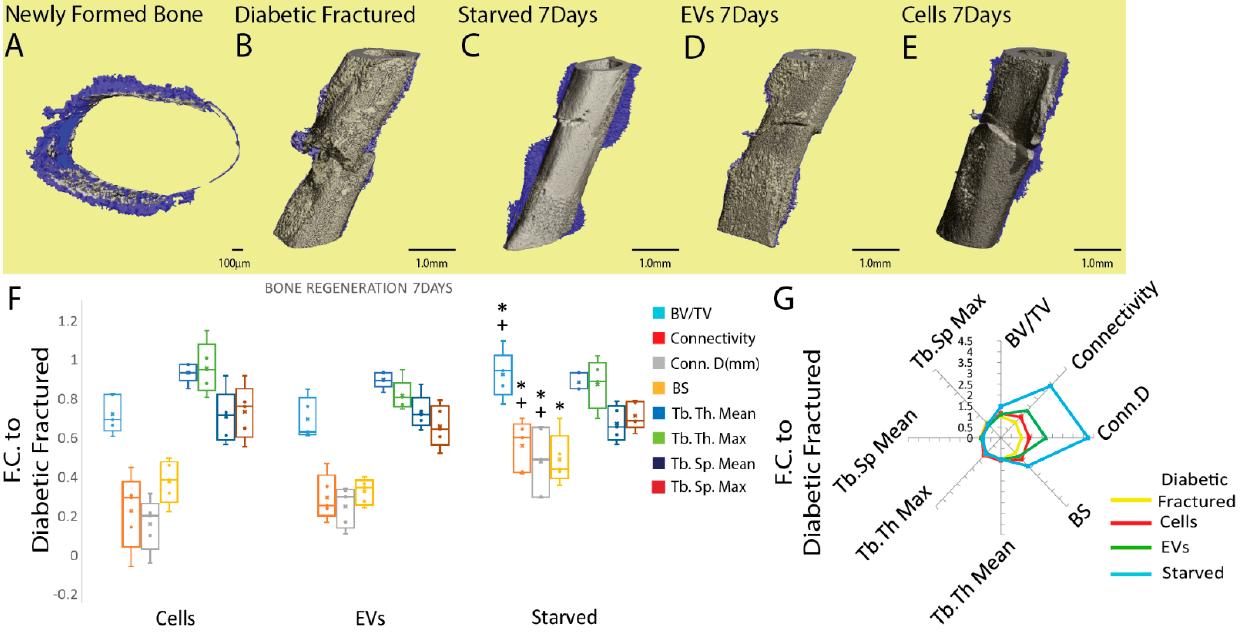
Figure 6. Analysis of the newly formed mineralized tissue five days after cells (starved and regularly fed) and EVs injections at the fracture site. ( A ) Three-dimensional fracture site reconstruction showing the presence of denser cortical lightly mineralized material adjacent to the fracture site highlighting the soft callus presence (blue) seven days post fracture. ( B – E ) Three-dimensional reconstruction of µ CT images from diabetic mice and diabetic mice treated with starved cells, EVs and regularly fed cells produced from the same donors showing the presence of decreasing amounts of denser lightly mineralized matrix (blue), delineating the soft callus formation, from ( B – D ). ( F , G ) Starved cell administration had a positive effect on mineral matrix deposition at the earlier time- point (7 days) for BV/TV ratio, connectivity, Conn.D (mm − 3 ) compared to regularly fed cell- and EV- injected animals and BS (mm 2 ) compared to EV-treated cells. No significant difference was seen between the treatments for trabecular Tb. Th. Mean (mm), Tb. Th. Max (mm), Tb. Sp. Mean (mm) and Tb. Sp. Max (mm). Data were normalized to diabetic animals with femoral fracture but receiv- ing PBS injection. Results are presented as mean fold change ± SD. p ≤ 0.05 * with respect to EVs, +cells (sample size four to five animals/group, one-way ANOVA followed by Fisher’s post hoc test). Scale bars: 100 μ m, 1 mm. Abbreviations: micro-computed tomography ( μ CT); regularly fed cells (cells); starved cells (starved); extracellular vesicles (EVs); fold change (F.C.); bone volume/total vol- ume (BV/TV); connectivity density (Conn.D (mm − 3 )); bone surface (BS(mm 2 )); trabecular thickness mean (Tb. Th. Mean (mm)); trabecular thickness max (Tb. Th. Max (mm)); trabecular spacing mean (Tb. Sp. Mean (mm)); trabecular spacing max (Tb. Sp. Max (mm)). Indeed, the starved cells’ injection resulted in a greater BV/TV ratio (1.46 ± 0.19), con- nectivity (3.41 ± 0.79), Conn.D (mm − 3 ) (4.23 ± 1.6) ( p ≤ 0.05 * with respect to EVs, + with